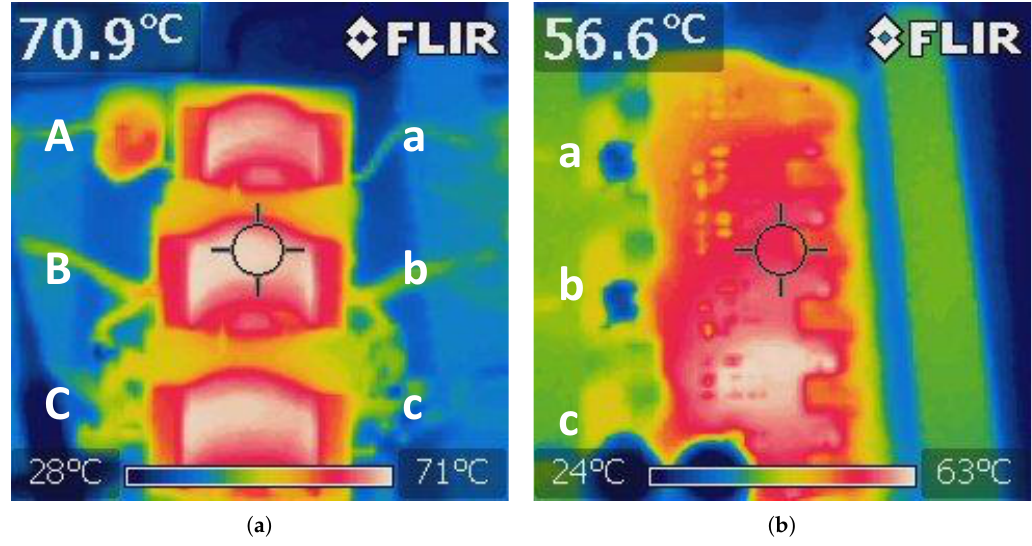
Figure 13. Temperature at 9.3 kW: ( a ) transformer and ( b ) secondary